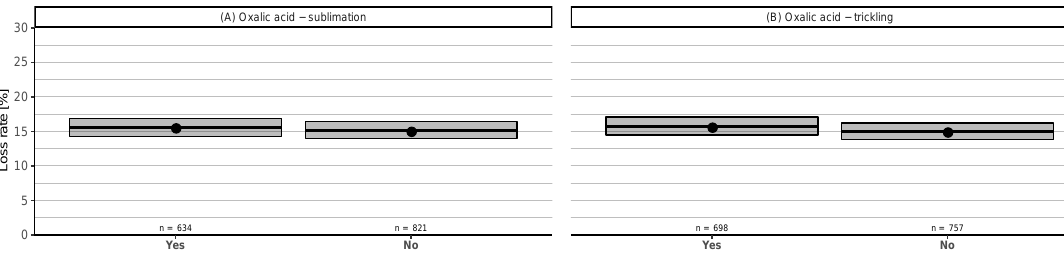
Figure A3. Treatment methods (yes = n > 19) used in summer 2018 (June–October) as single factors to winter honey bee colony loss rates (and 95% CI): To improve sample size, synthetic methods were grouped together and the oxalic mixture was added to oxalic trickling.